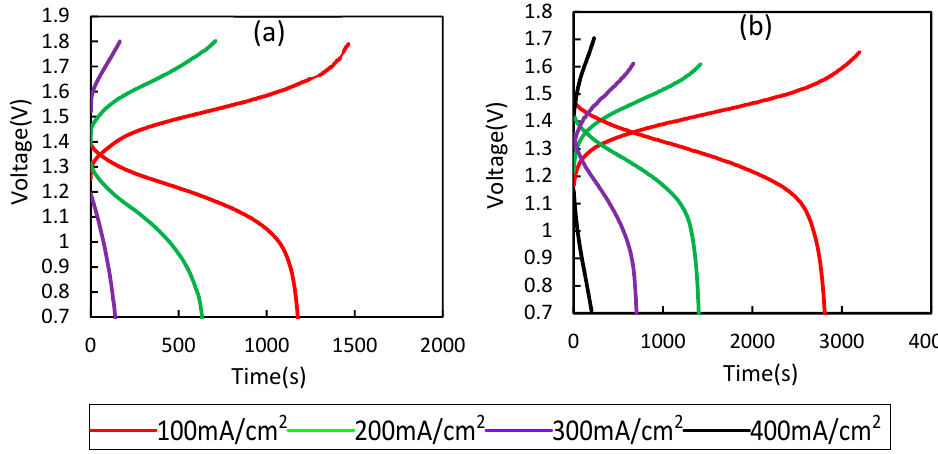
Figure 5. Charge and discharge data. ( a ) Constant-current charge/discharge experiment for untreated electrode. ( b ) Constant-current charge/discharge experiment of treated electrode. Table 2. Constant Current Charge and Discharge Data (A: Untreated Carbon Felt; B: Treated Carbon Felt).